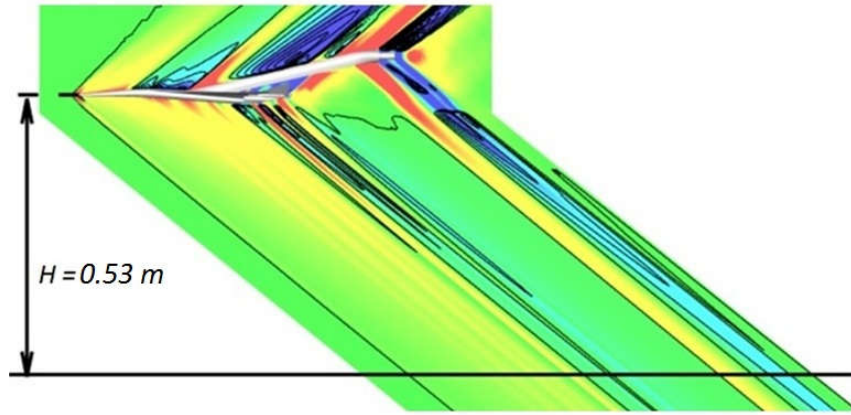
Figure 26. Result estimation scheme (LM1021).